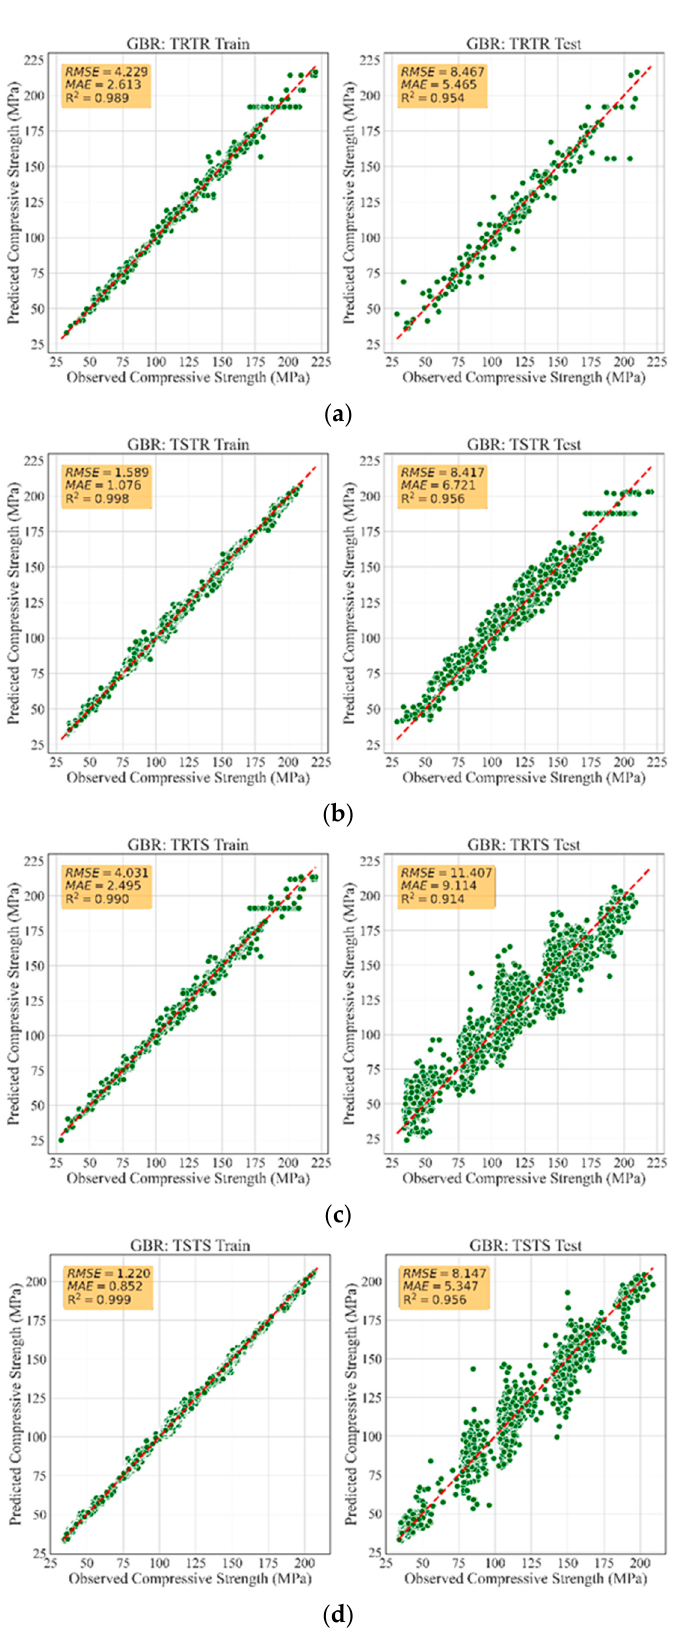
Figure 5. Training and testing performance of GBR model: ( a ) TRTR; ( b ) TSTR; ( c ) TRTS, and ( d ) TSTS.